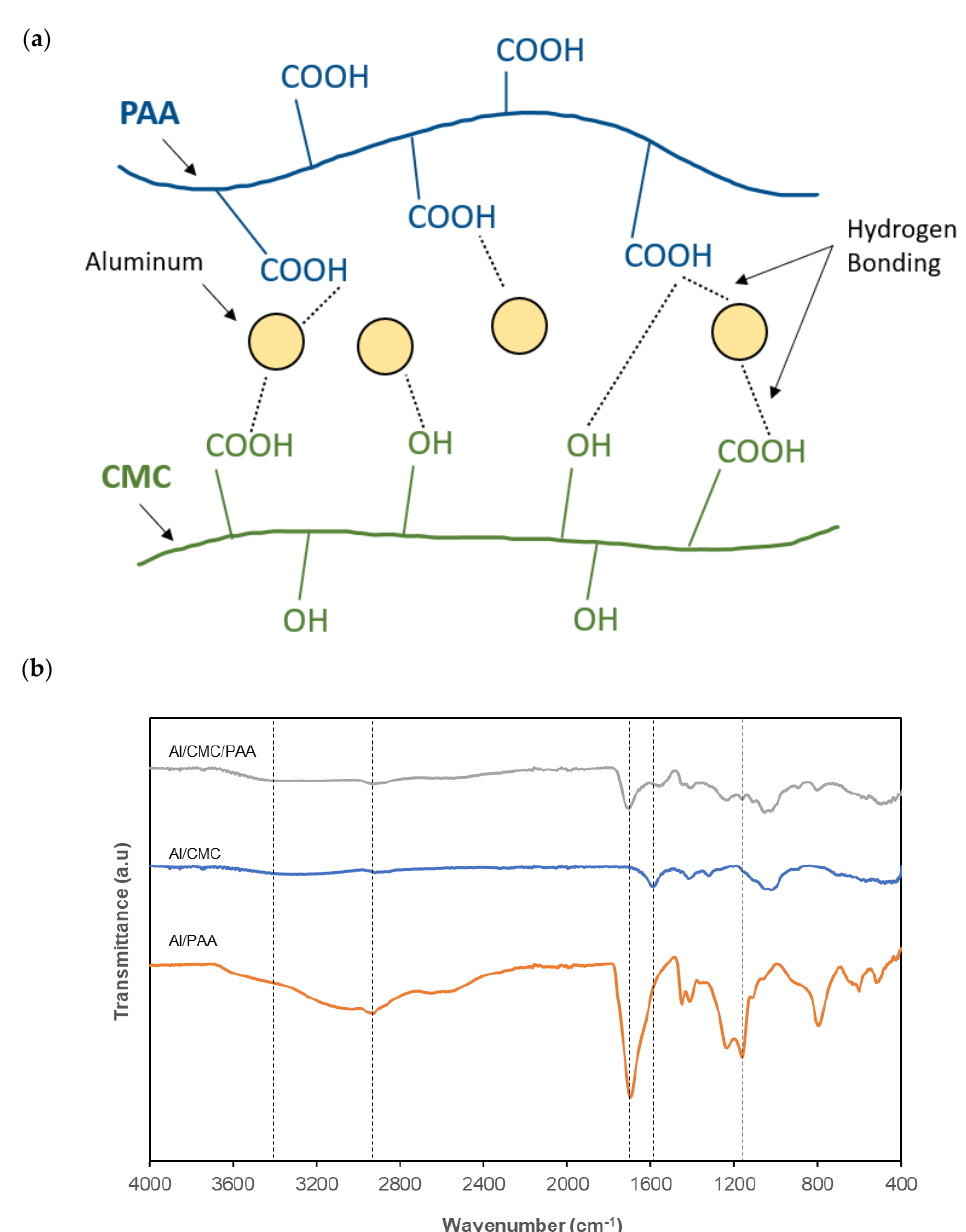
Figure 5. Proposed crosslinking mechanism in the AAs ( a ), and the FTIR spectrum of the AAs ( b ). To develop hydrophobic AA, the samples were uniformly coated with MTEOS. Wa- ter contact angles of the coated AAs were measured. Figure 6 shows the water contact angles were approximately 123°. The coated AAs exhibited water contact angles between 110 and 129°. Across the surface of each sample tested, the hydrophobicity of the AAs was observed to be approximately similar with no significant difference between the water contact angles obtained.